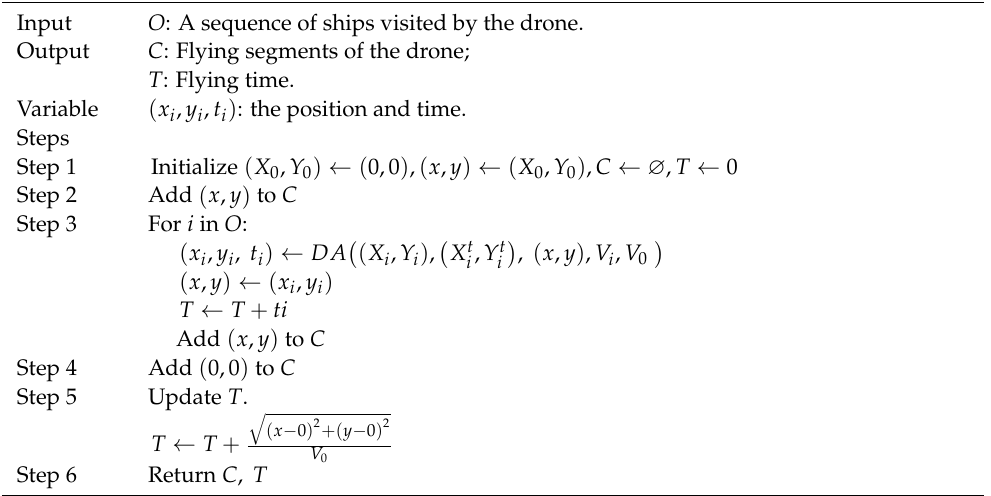
Algorithm 2 Sequence-based construction algorithm